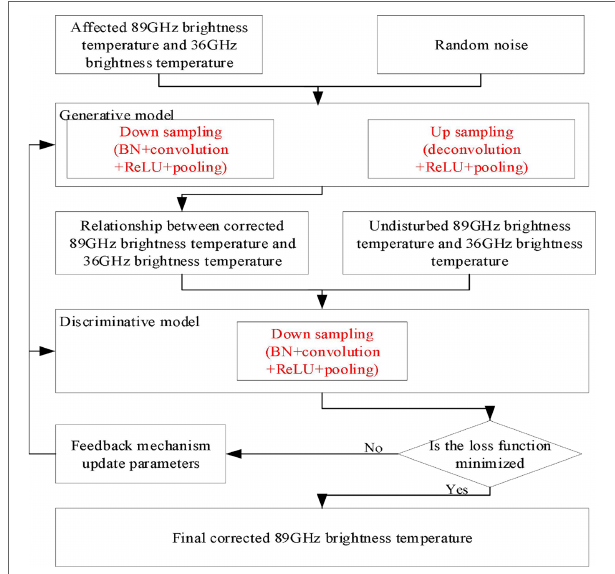
FIGURE 2 | Flowchart of the affected 89-GHz brightness temperature data correction based on CGAN